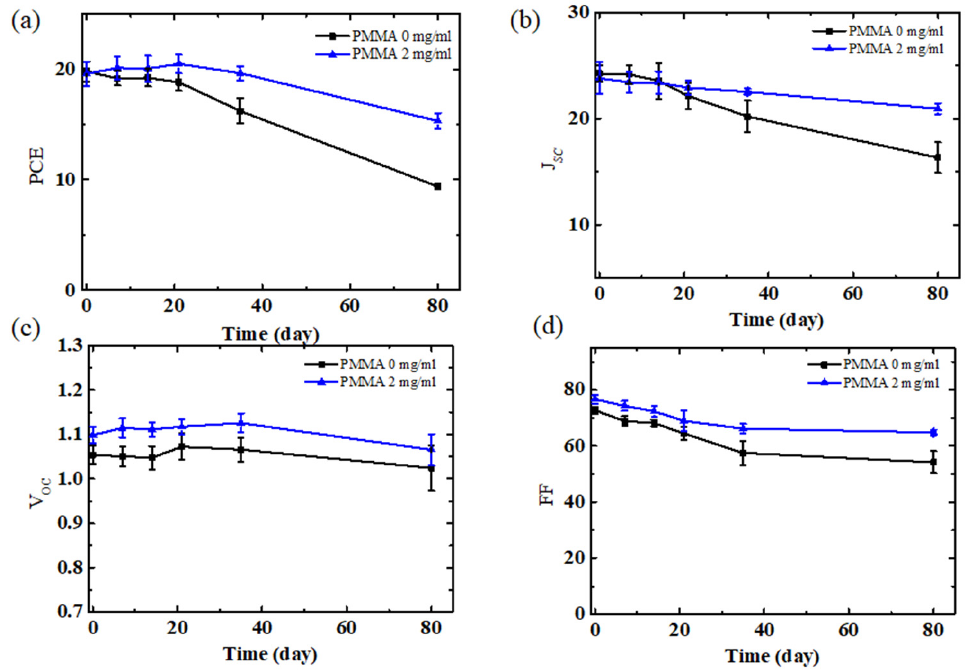
Figure 4. The statistical device stabilities of ( a ) PCE, ( b ) J SC , ( c ) V OC , and ( d ) FF of spiro-OMeTAD and PMMA (2 mg/mL): spiro-OMeTAD-based cells. These devices were kept in the air environment with RH = 40% for 80 days.